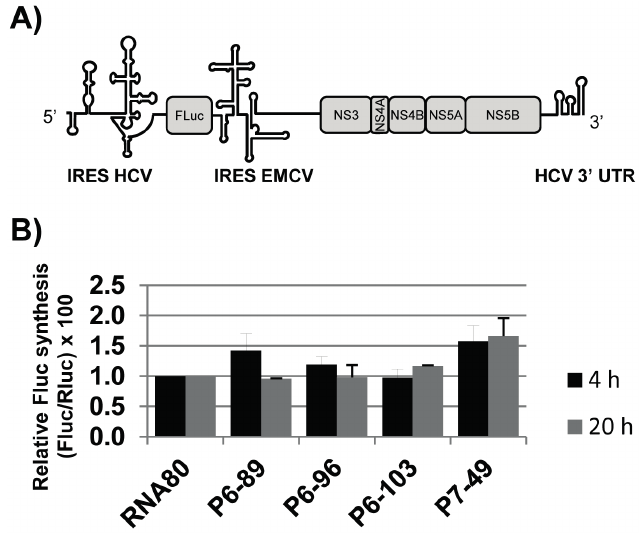
Figure 6. Effect on HCV translation of the aptamers P6-86, P6-96, P6-103, and P7-49 in Huh-7 cells. ( A ) Schematic diagram showing the genetic organization of the reporter dicistronic replicon Rep-FLuc used in this study; ( B ) Huh-7 cells were co-transfected by electroporation with the RNA aptamers and 5.2 μ g of a mixture containing the transcripts Rep-FLuc and cap-RLuc. HCV IRES activity was measured as the activity of FLuc protein and referred to that obtained for RLuc. Luciferase activity in the control reactions with the non-related RNA80 is established as 100%. Data points are the mean of three independent